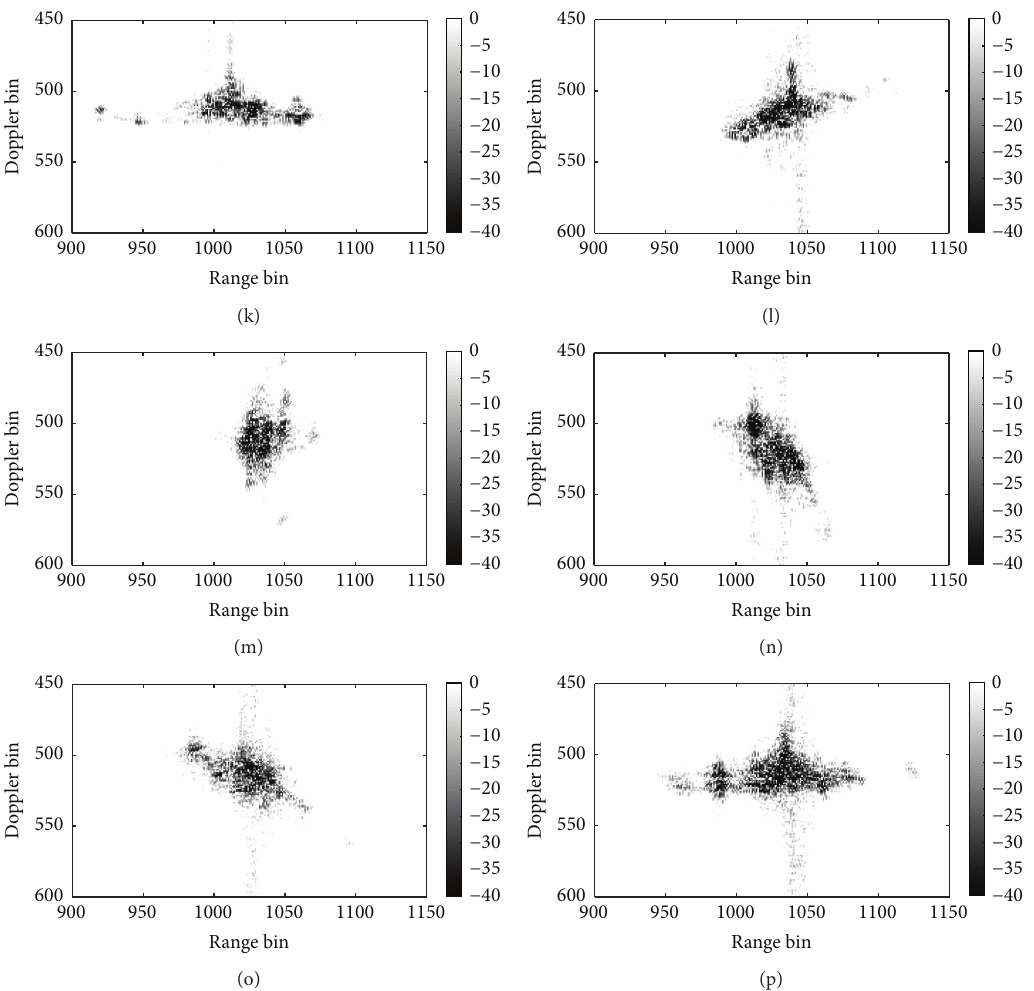
Figure 15: ISAR images of cooperative target. (a) Side-looking image at 11:55, (b) oblique-looking image at 11:58, (c) oblique-looking image at 12:01, (d) oblique-looking image at 12:04, (e) front-looking image at 12:06, (f) oblique-looking image at 12:08, (g) oblique-looking image at 12:11, (h) oblique-looking image at 12:14, (i) oblique-looking image at 12:17, (j) side-looking image at 12:20, (k) side-looking image at 12:22, (l) oblique-looking image at 12:23, (m) front-looking image at 12:26, (n) oblique-looking image at 12:27, (o) oblique-looking image at 12:29, and (p) side-looking image at